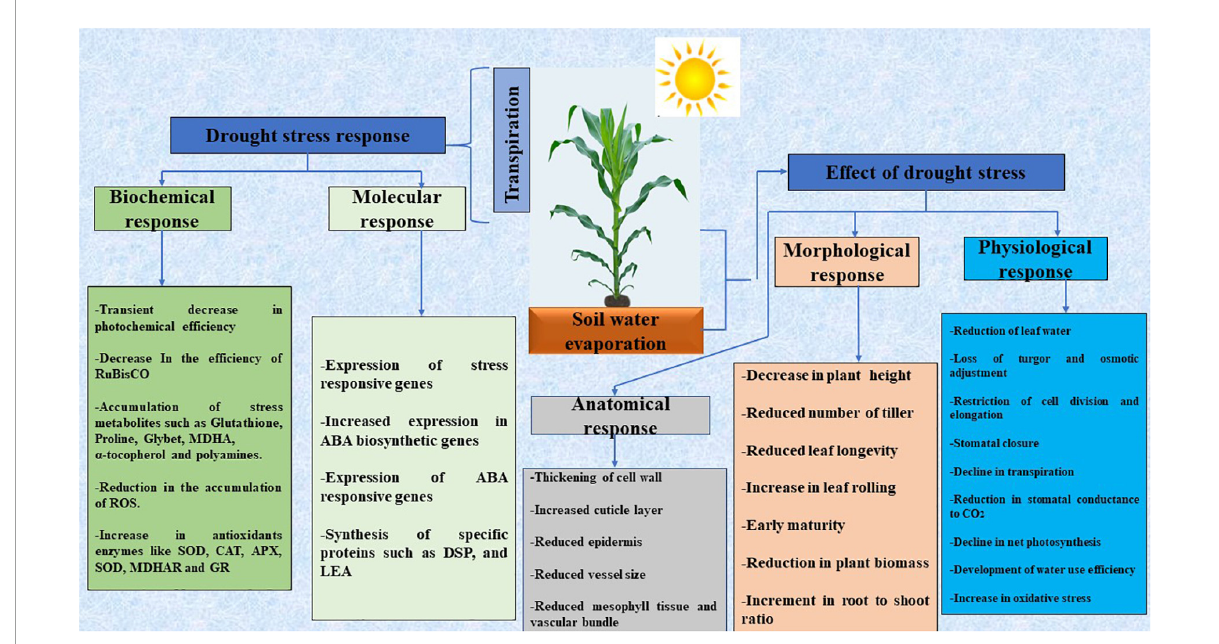
FIGURE1 A diagrammatic representation of the responses of plants to drought stress. Adapted from Mamédio et al. (2020). MDHA, Monodehydroascorbate; MDHAR, Monodehydroascorbate reductase; SOD, Superoxide dismutase; APX, Ascorbate peroxidase; POD, Peroxidases; GR, Glutathione reductase; LEA, Late embryo abundant; DSP, Dual-specificity